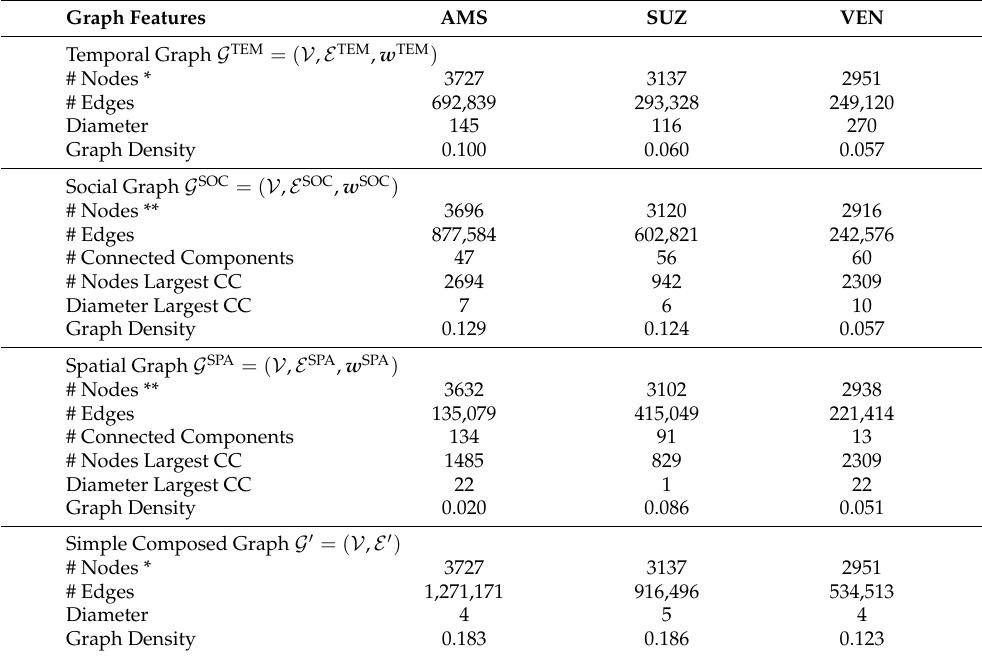
Table 7. The statistics for the multi-graphs. “#” means “the number of” in the table. Graph Features AMS